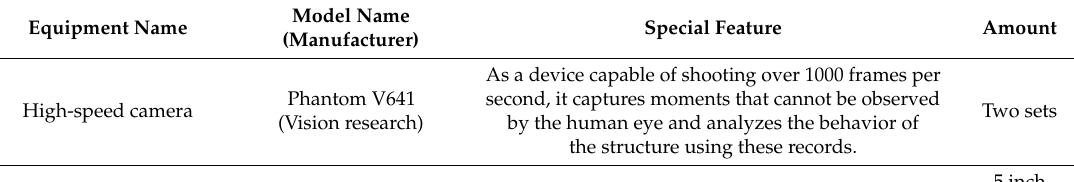
Table 2. Equipment and features used in high-speed camera shooting and image analysis.